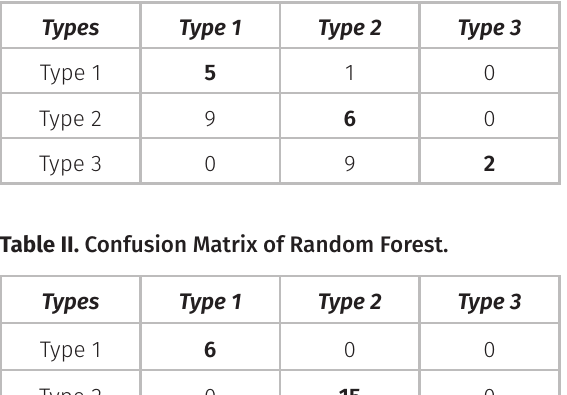
Table I. Confusion Matrix of Naive Bayes.